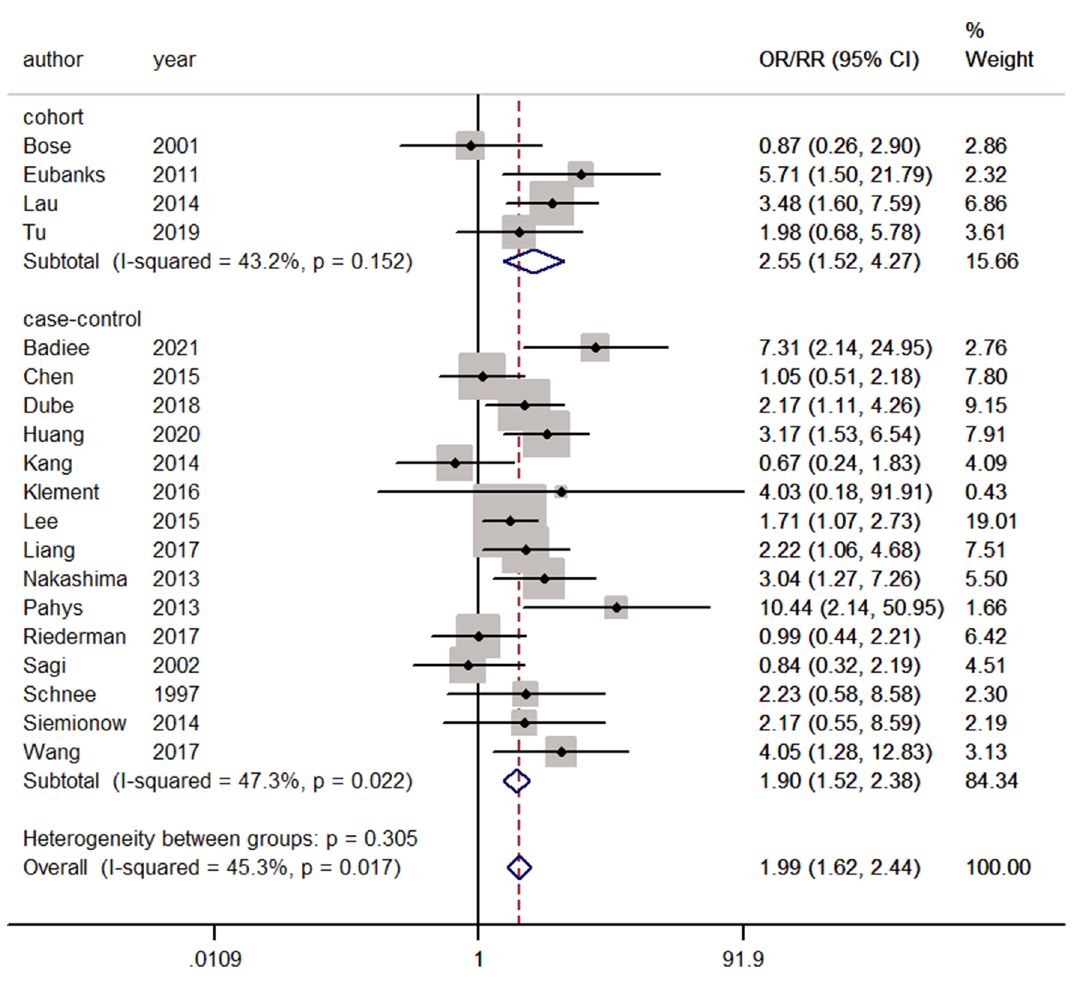
Figure 2. Forest plot showing the effect of smoking on overall complications. OR, odd rate; RR, risk rate; CI, confidence